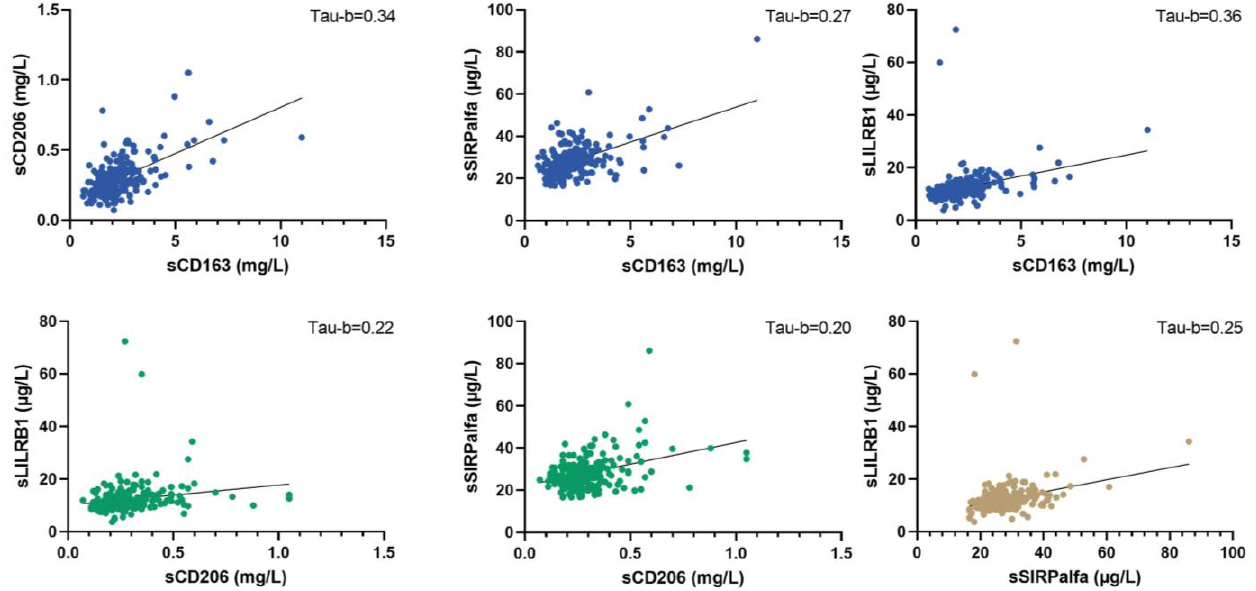
Figure 2. The correlations between the different macrophage biomarkers. The Kendall Tau-B coef- ficient determined the strength of the association. Tau-b for sCD206 vs. sCD163 = 0.34 (strong asso- ciation); tau- b for sCD163 vs. sSIRPα = 0.27 (medium to strong association); tau -b sCD163 vs. sLILRB1 = 0.36 (strong association). Tau- b for sCD206 vs. sSIRPα = 0.20 (weak association to medium association); tau-b for sCD206 vs. sLILRB1 = 0.22 (medium association). Tau- b for sSIRPα vs. sLILRB1 = 0.25 (medium association).